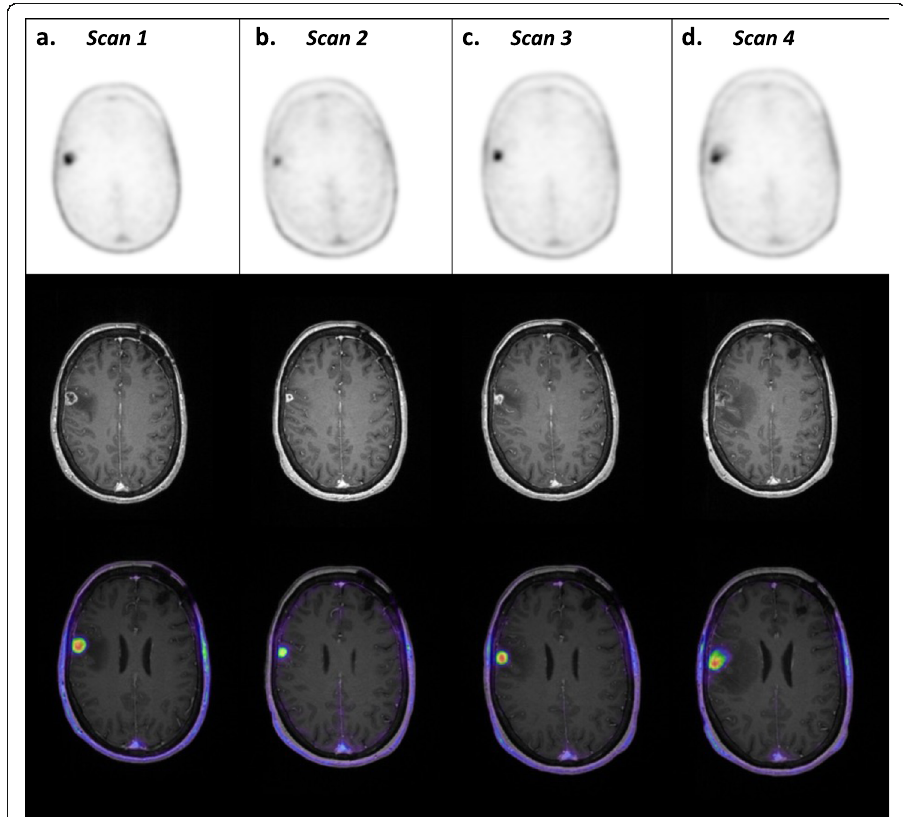
Fig. 1 Static PET, T1 MRI CE and fused PET/MR images of the cerebral tumour from scans 1 – 4. Axial view of the patient ’ s metastasis in the lateral precentral gyrus of the right hemisphere acquired using hybrid PET/ MR imaging at four time points: scan 1 — before stereotactic radiation, scan 2 — 1 month after the end of stereotactic radiation, scan 3 — on suspicion of recurrence 1 month after scan 2, and scan 4 — 1 month after scan 3. Static PET (20 – 35 min), T1 MRI CE and fused PET/MR images are shown from the top to bottom rows, respectively. Columns a – d show scans 1 – 4. The SUV scale for static PET images was 0 – 3.3, and the SUV scale of fused PET/MR images was 0.45 –